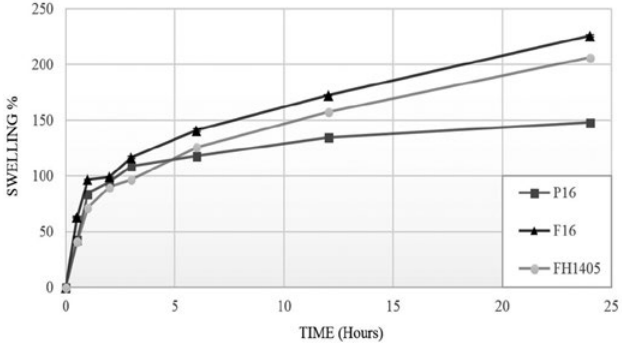
FIGURE 2 - Swelling profiles of in situ gel formulations